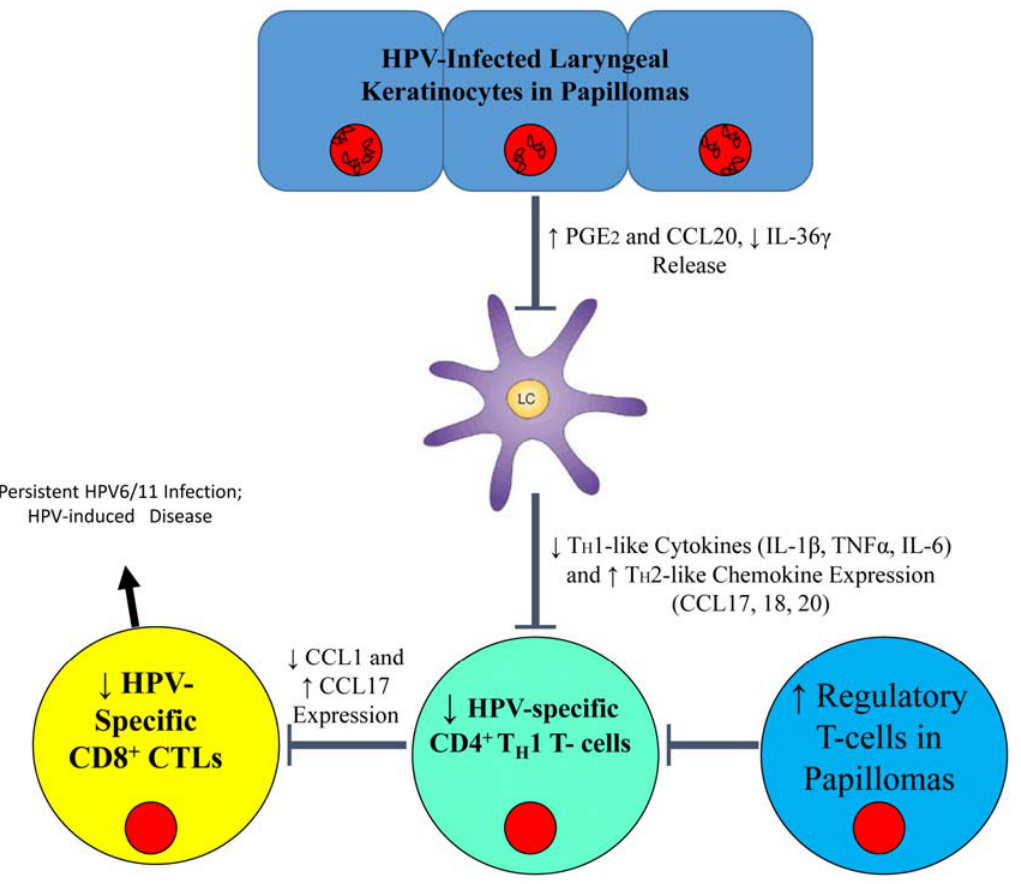
Figure 2. Innate Signaling of HPV 6/11-infected Keratinocytes Modulates the Immune Response in RRP. Keratinocytes harboring persistent HPV-infection have increased levels of PGE 2 and CCL20, while levels of the pro-inflammatory cytokine IL-36 γ are decreased. The alterations in this cytokine milieu inhibit the normal activation of Langerhans cells, which in turn reduces the number of HPV-specific T H 1 cells in the lesion and supports regulatory T-cell differentiation from T H 0 T-cells. In addition, the localized polarization of T cells toward a T H 2 phenotype reduces the T H 1 population in the lesion. Lack of HPV-specific T H 1 cells, results in low levels of HPV-specific CD8+ cells that supports a micromilieu of immune suppressive cells, chemokine, and cytokines that supports persistent HPV